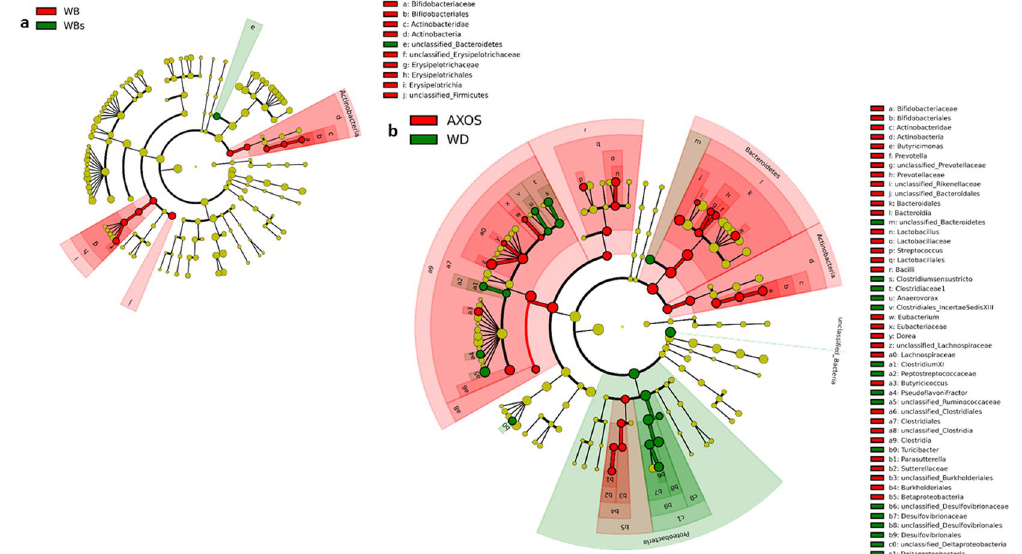
Figure 2. Discriminant analysis of the cecal microbiota using LEfSe. Mice were fed a control diet (CT), a western diet (WD), a WD supplemented with 5% of wheat bran fraction with large particles (WD + WB), a WD supplemented with 5% of wheat bran with reduced particle size (WD + WBs) or a WD supplemented with 5% of AXOS (WD + AXOS) for 8 weeks. Discriminant analysis between WB and WBs ( a ). Taxa enriched in the WB group are highlighted in red whereas taxa enriched in the WBs group are highlighted in green. Discriminant analysis between AXOS and WD ( b ). Taxa enriched in the AXOS group are highlighted in red whereas taxa enriched in the WD group are highlighted in green.